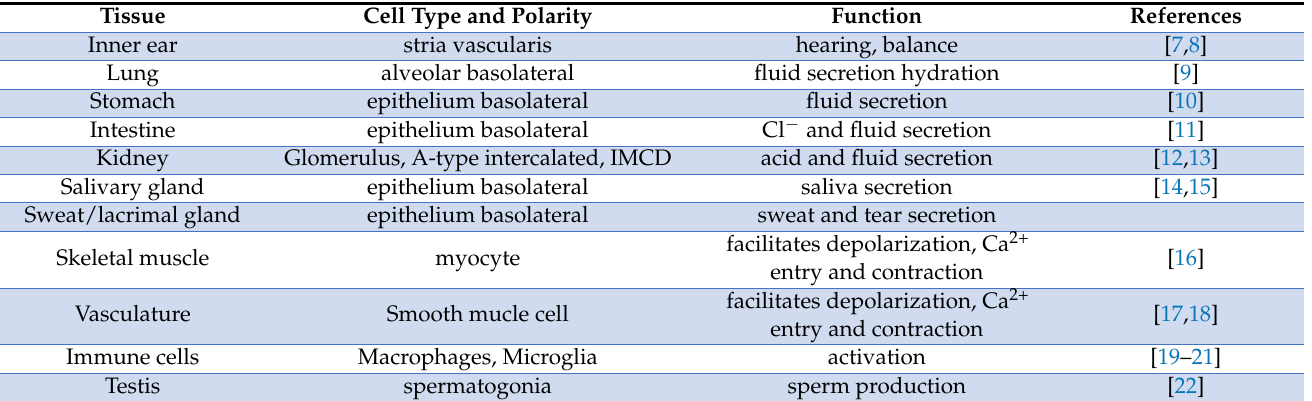
Table 1. Expression and Function of NKCC1 in the